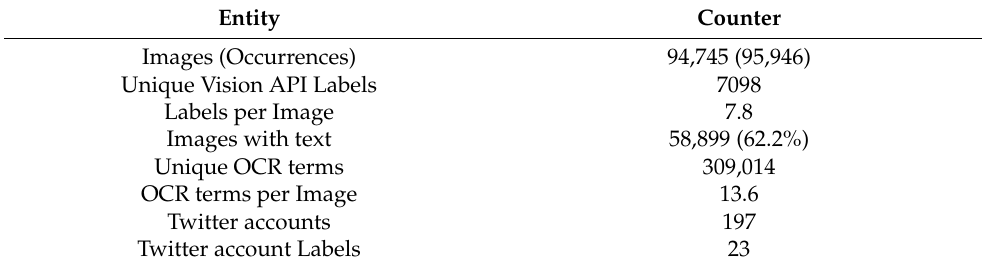
Table 4. Full dataset